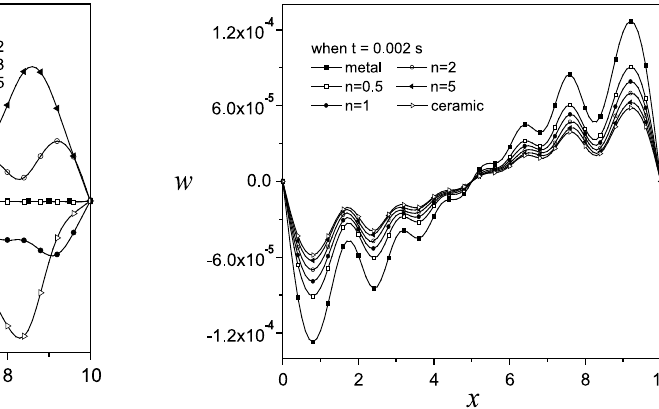
Fig. 23. Deflection of the mid-plane for the simply supported FGPM cylindrical shell imposed by a cosine distributed load, when t = 0 . 002